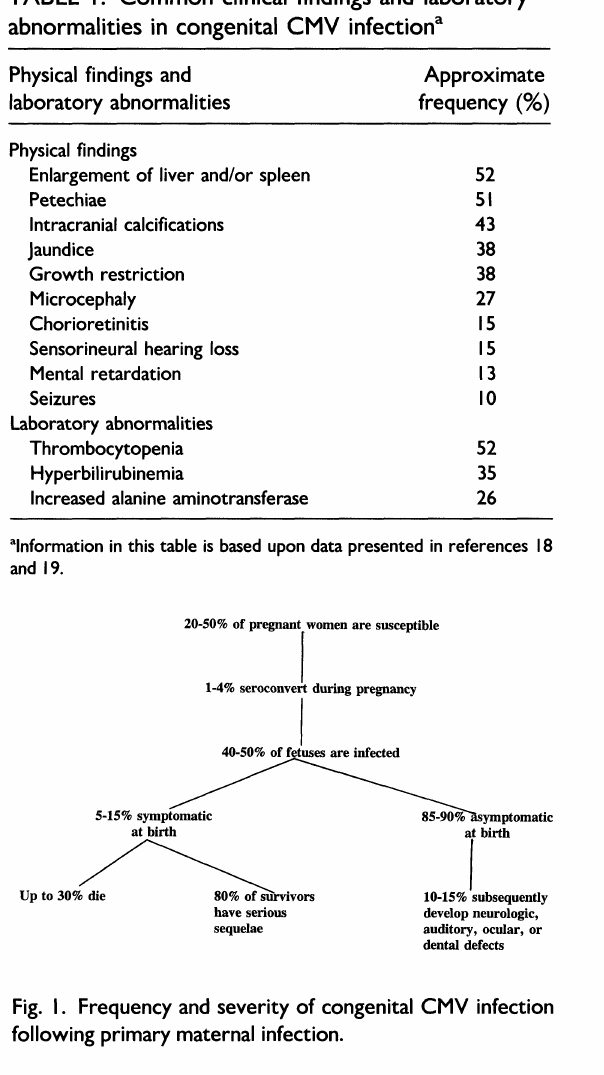
Fig. I. Frequency and severity of congenital CMV infection following primary maternal